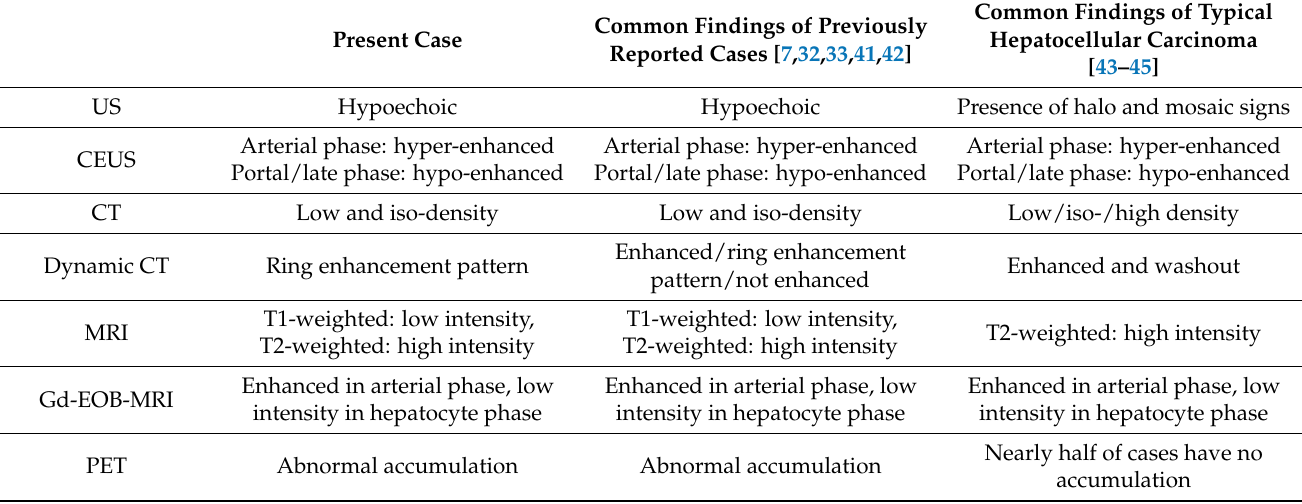
Table 3. Comparison of image findings among the present case, previously reported cases, and typical hepatocellular carcinoma.